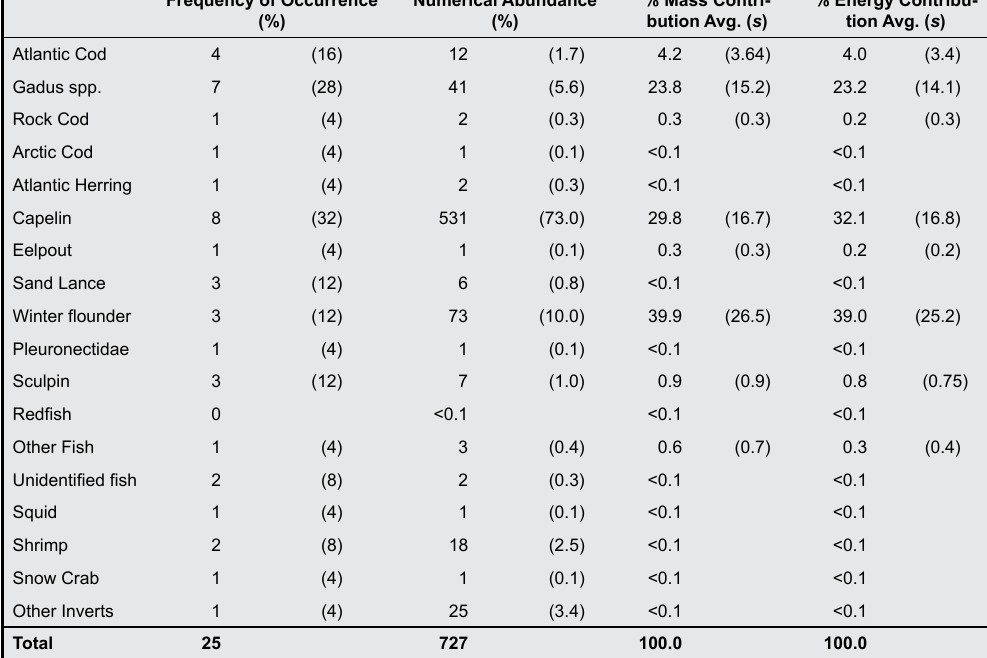
Table 8. Diet composition of 25 seals collected from the east coast of Newfoundland and south- eastern coast of Labrador between 1985 and 2004. Frequency of occurrence and % frequency of occurrence in parentheses, numerical abundance with relative percent in parentheses, and percent (%) mass and energy contribution to the diet, average with standard deviation in paren-